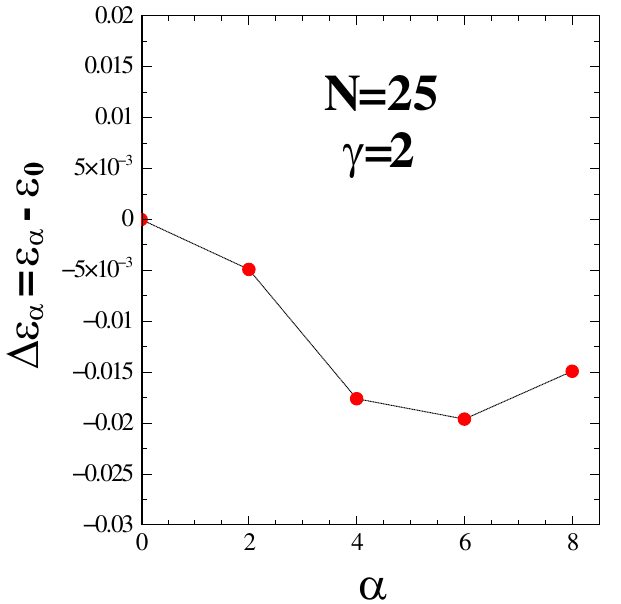
ǫ α ǫ 0 as a function of the wave function anisotropy = − 25 electrons at filling factor ν 1 / 6 of the LLL. The anisotropic = = 2 . Energies are in units of e 2 / l 0 The statistical =